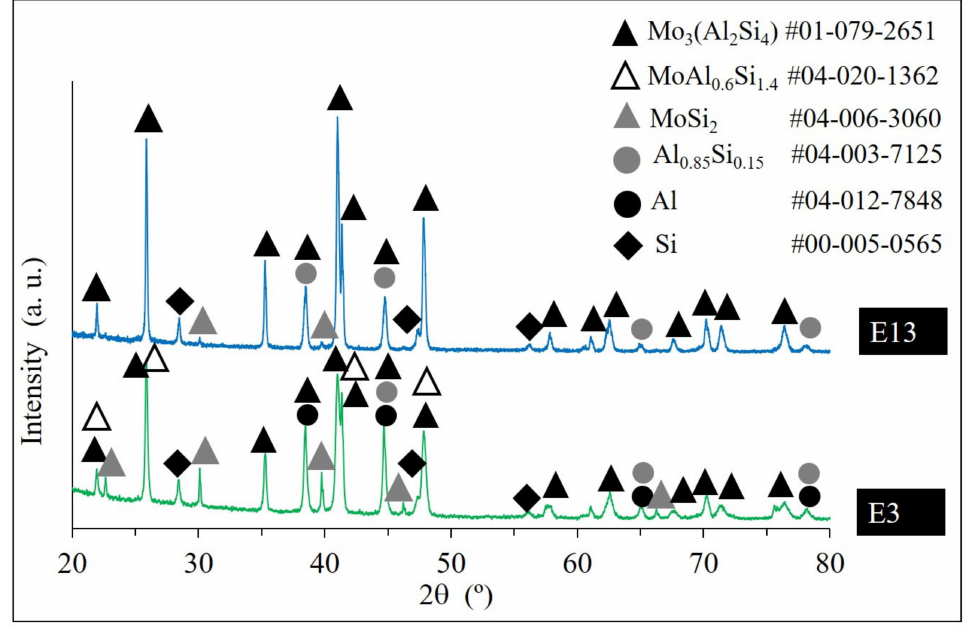
Figure 8. X-ray di ff raction (XRD) patterns of samples E13 and